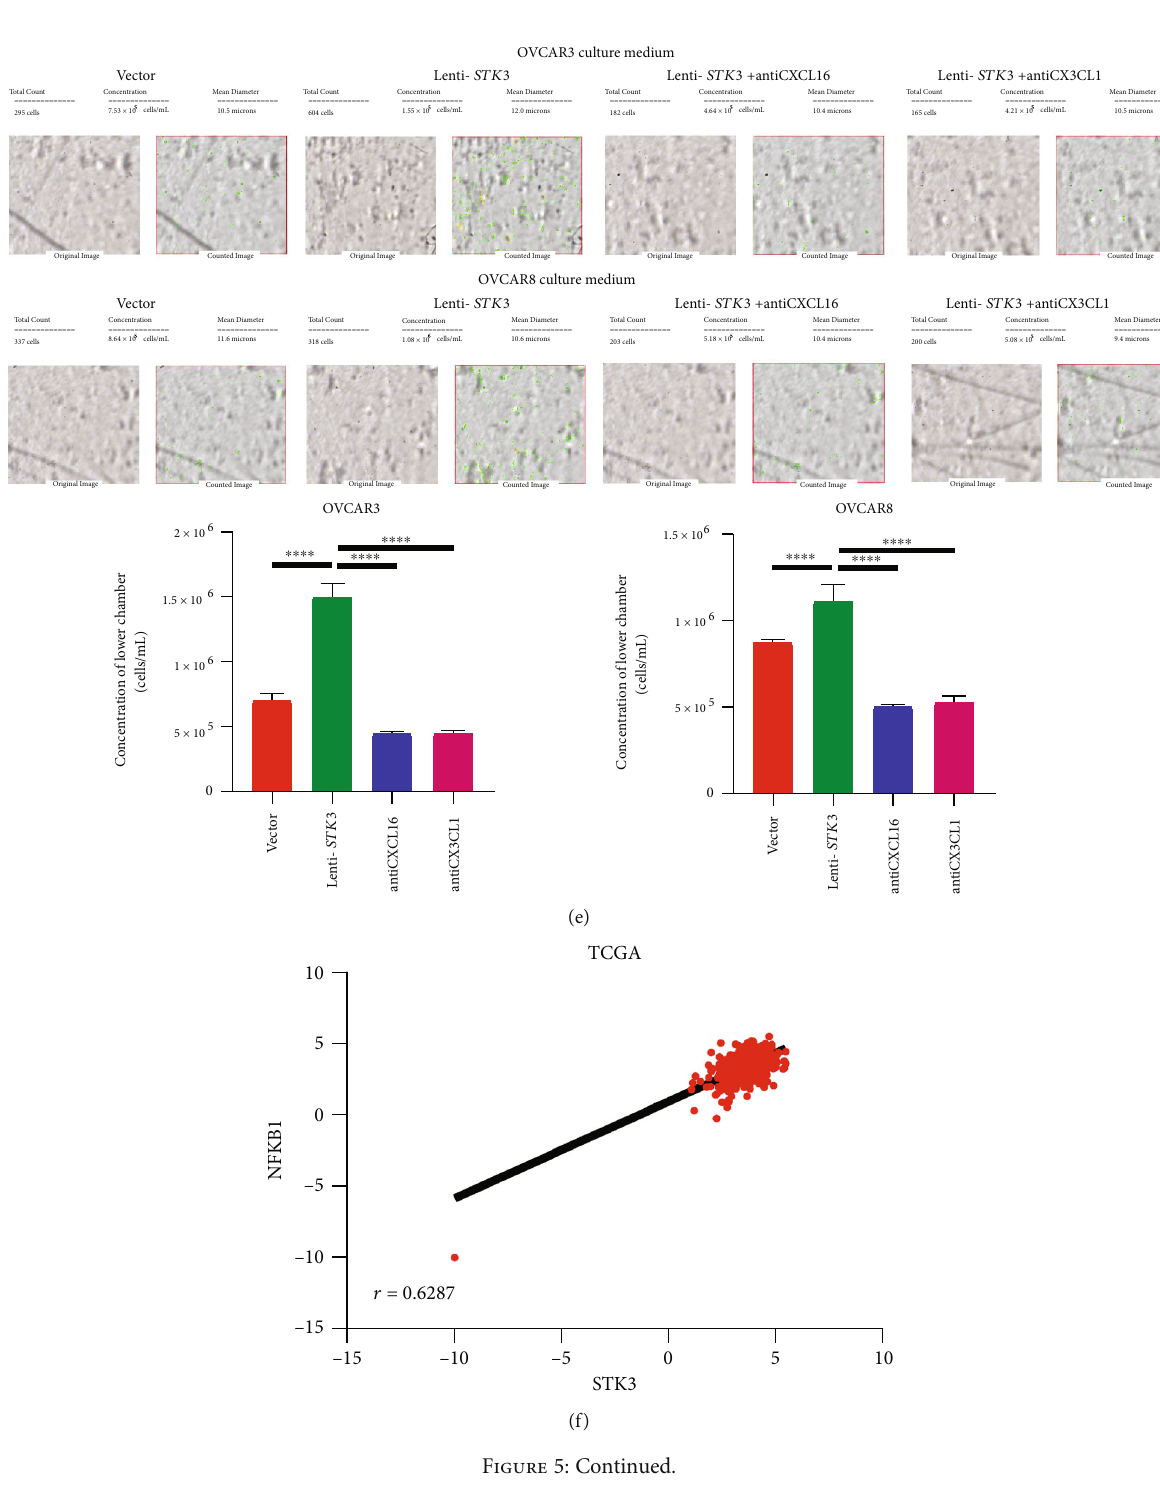
cells============== Mean Diameter ============== 12.0 micronsConcentration 604